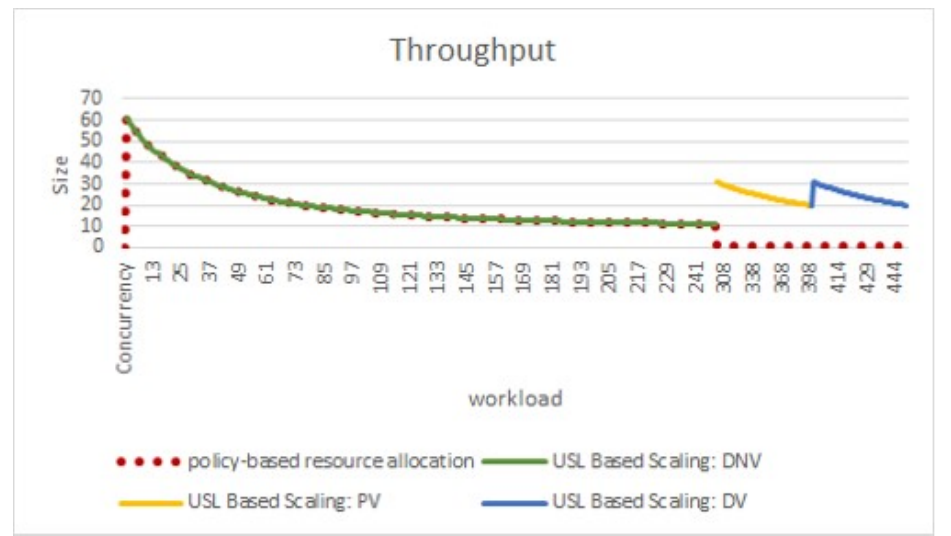
Figure 7. QoS Satisfied Throughput.